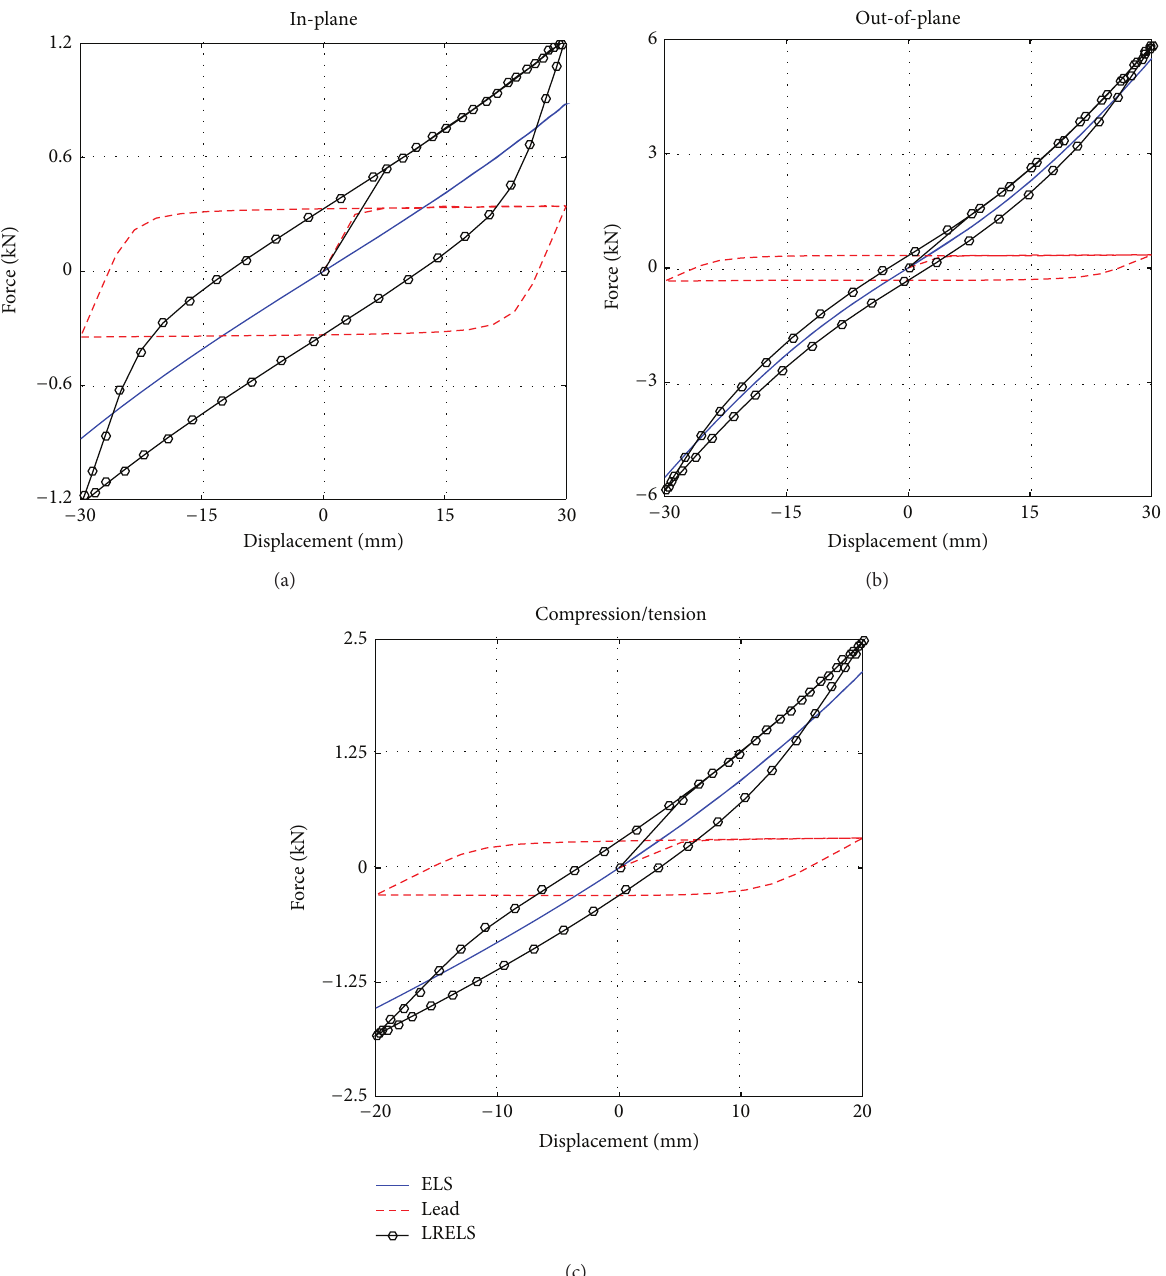
Figure 4: Force-displacement curves for LRELS 1: (a) in-plane (b); out-of-plane; (c) compression/tension.